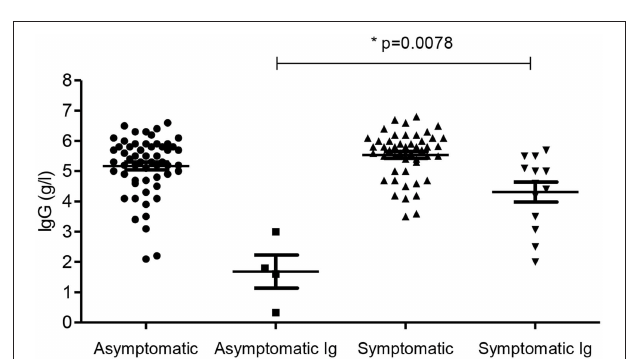
FIGURE 3 | IgG levels in the four groups. Subgroups accepted for SCIG/IVIG are also shown. Ig- patients accepted for SCIG/IVIG. *The asymptomatic Ig group was compared to the symptomatic Ig group by the Mann–Whitney U -test.